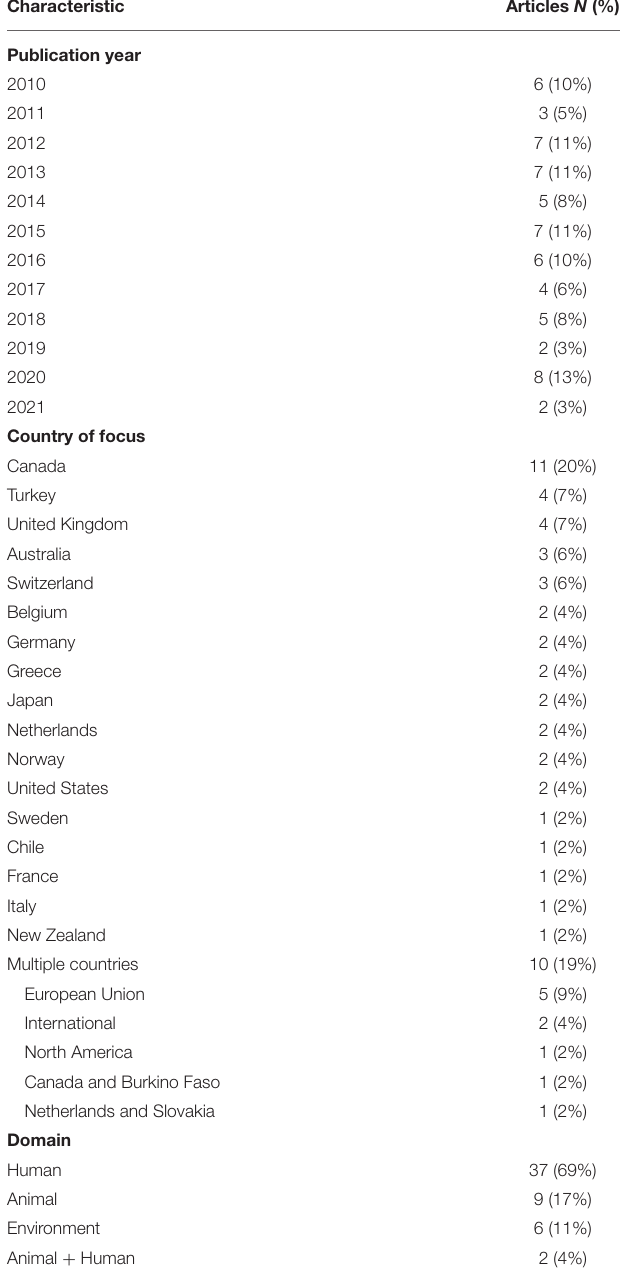
TABLE 1 | Summary of article